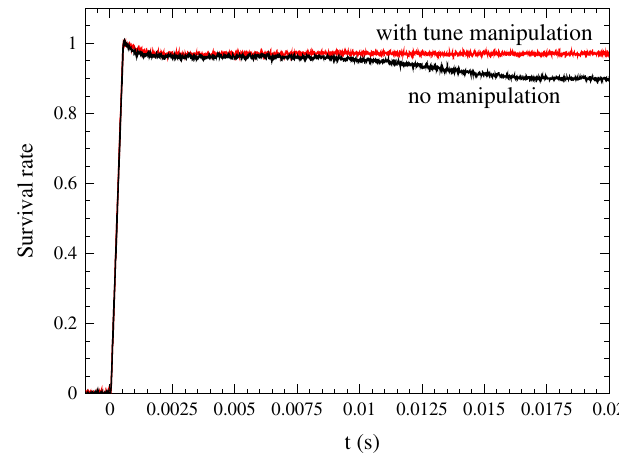
FIG. 26. (Color) Beam survival rates as a function of the revo- lution time measured with no beam painting scheme using DCCT, where 5 (cid:2) 10 12 protons per bunch were injected to the RCS. The beam loss observed for the latter half of the accelera- tion period was improved by the tune variation shown in Fig.